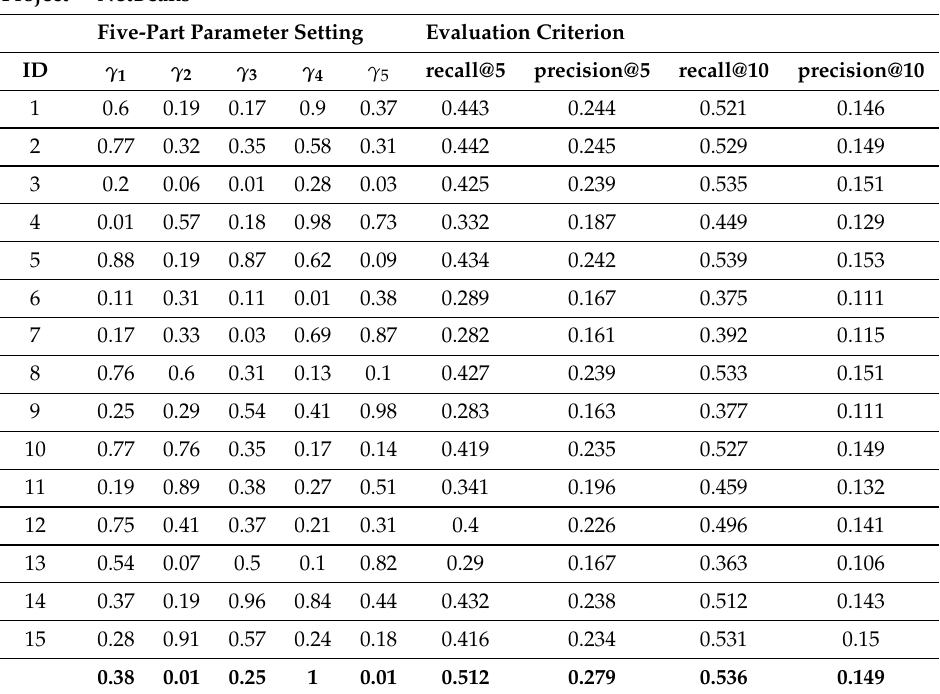
Table 8. Effects of different parameter settings on experimental results for the NetBeans dataset, and the last behavior in the table is the parameters measured by our proposed ABC-DR algorithm for the NetBeans